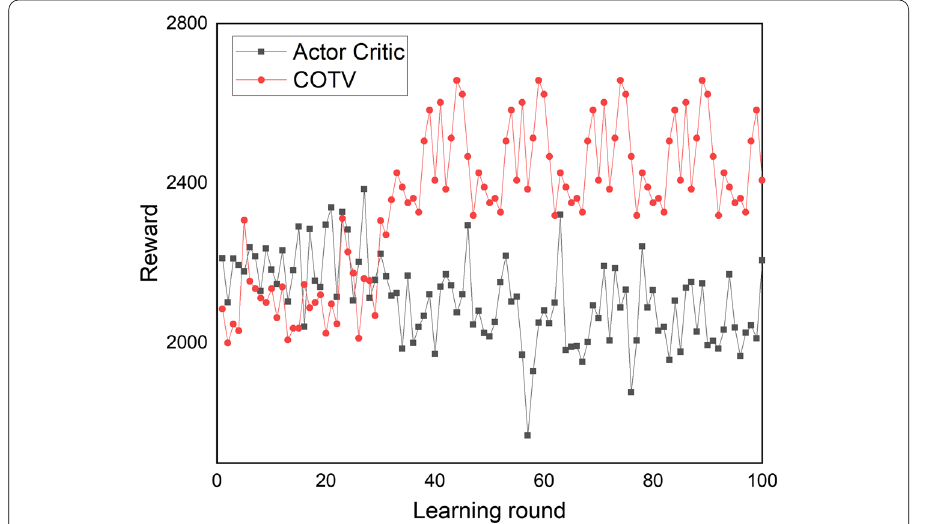
Fig. 2 Reward versus learning